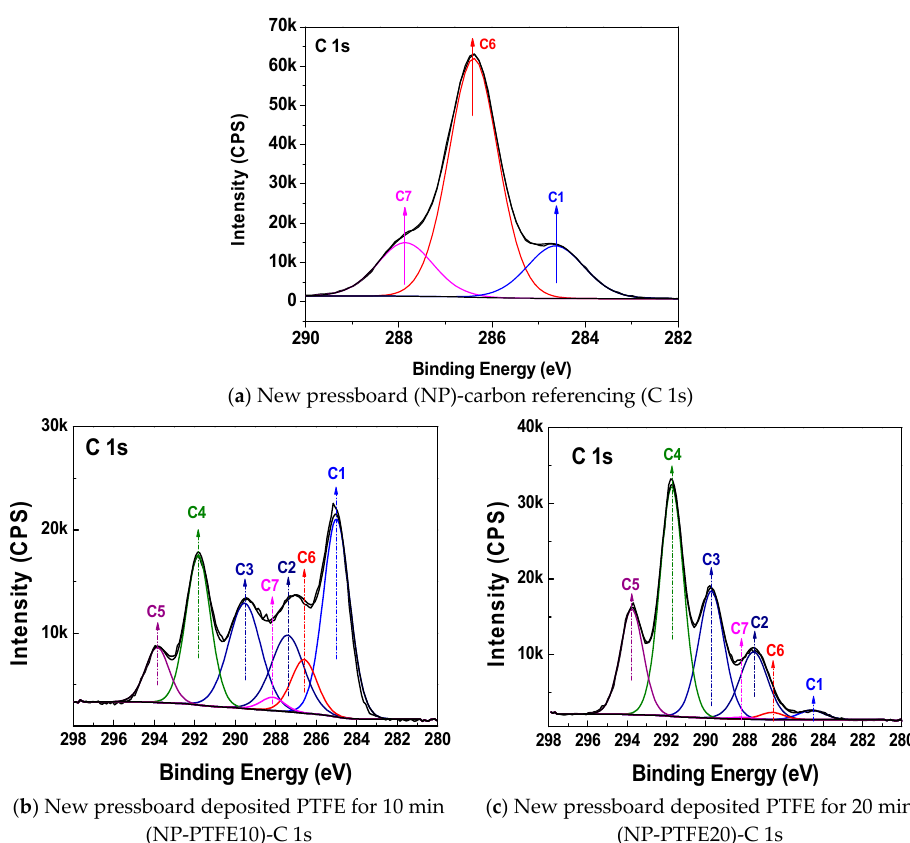
Figure 4. C 1s peak fitting for the new pressboard ( a ), new pressboard coated PTFE film for 10 min ( b ), and 20 min ( c ).